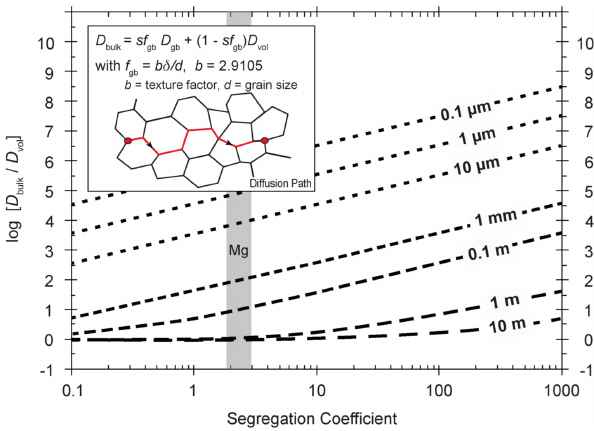
Figure 14. Dependency of D bulk on grain size and segregation coef- ficient. For calculating the bulk diffusion coefficient, D gb and D vol from the experimentally determined Fe diffusion at 1450 ◦ C were used. D bulk is calculated according to a modified Hart equation (Hart, 1957) as suggested by Mortlock (1960). It governs the mo- bility of elements in a polycrystalline aggregate, and hence it con- trols when non-touching grains can exchange elements with each other. The equation is applicable for the type-A and type-A (cid:48) kinetic